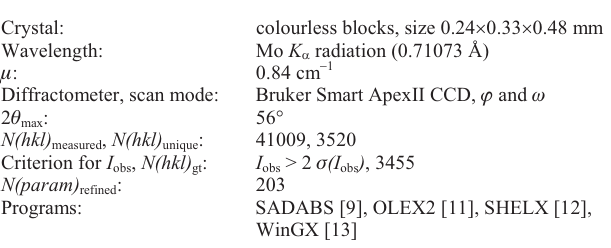
Table 1. Data collection and handling.